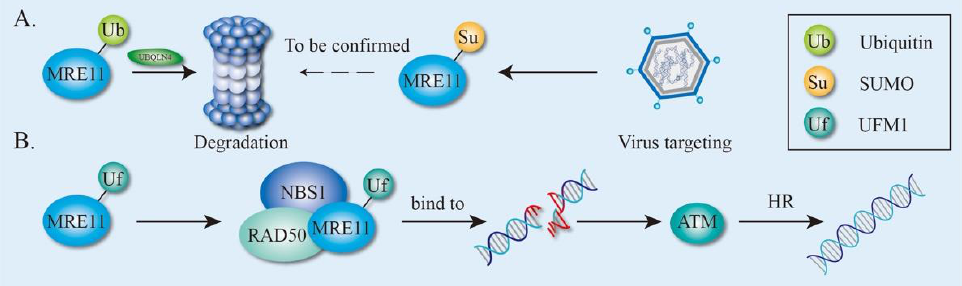
Figure 5. The effect of ubiquitination and ubiquitin-like modification of MRE11. ( A ) The effect of MRE11 ubiquitination and SUMOylation. MRE11 ubiquitination promotes its degradation mediated by UBQLN4 through proteasome and SUMO-MRE11 is targeted by adenovirus. ( B ) The effect of MRE11 UFMylation. MRE11 UFMylation promotes MRN complex formation and DNA repair. HR, homologous repair.